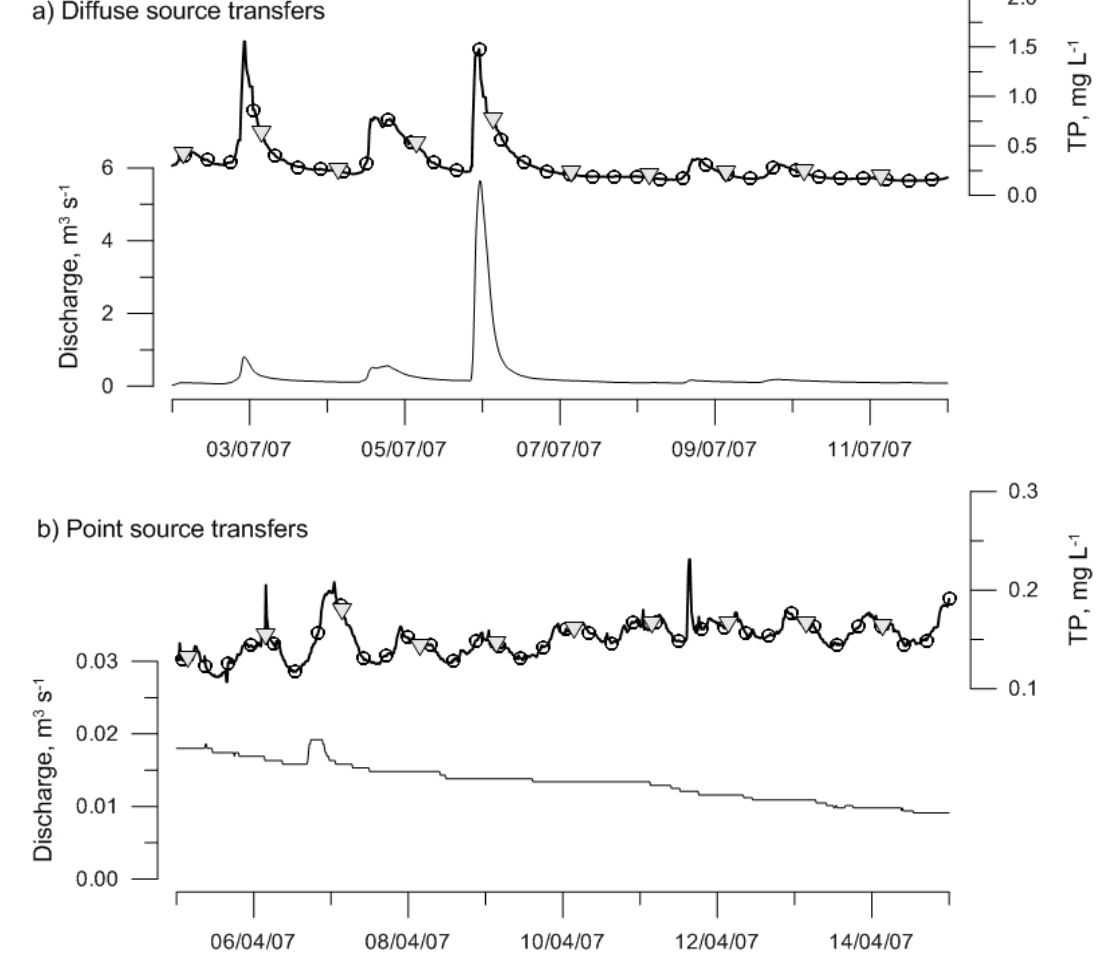
Fig. 2. Representation of a period of discharge and diffuse P transfer during a diffuse storm event (a) with sub-hourly data (solid line), 7 hourly sampling (open circles) and daily sampling (closed triangles). Seven hourly sampling is more likely to capture important times of hydrograph and chemograph development. Also, (b) important diurnal signals during point source P transfers are better represented using the 7 hourly sampling and are missed with daily sampling which, by coinciding with a daily peak in the cycle, may overestimate mean daily low flow concentrations (and similarly underestimate if sampled 12h